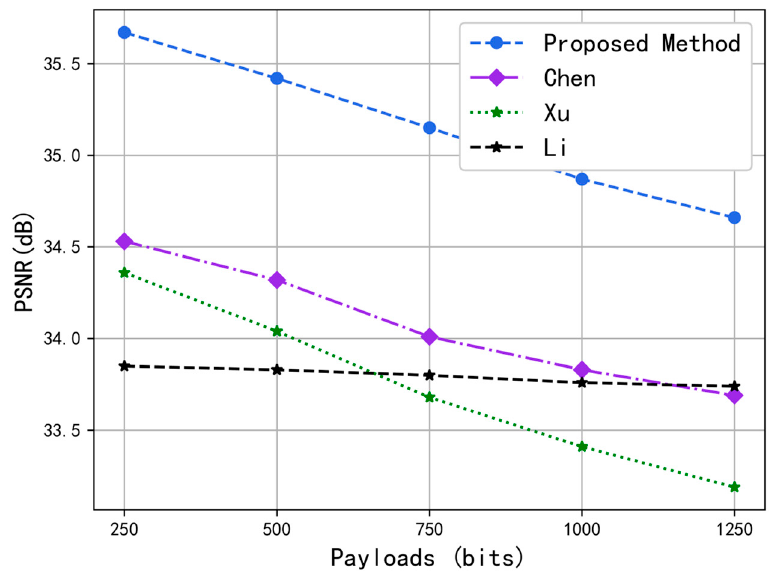
Figure 9. Comparison of PSNR values of different schemes on Mobile.